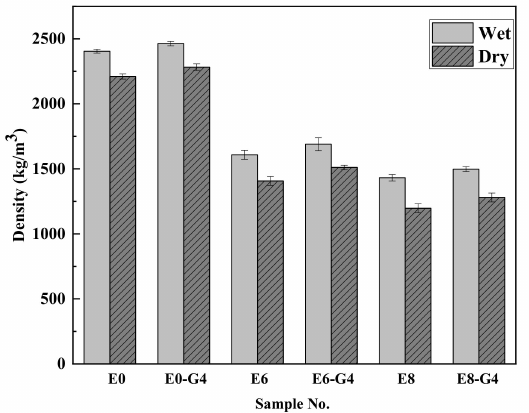
Figure 9. The wet and dry densities of